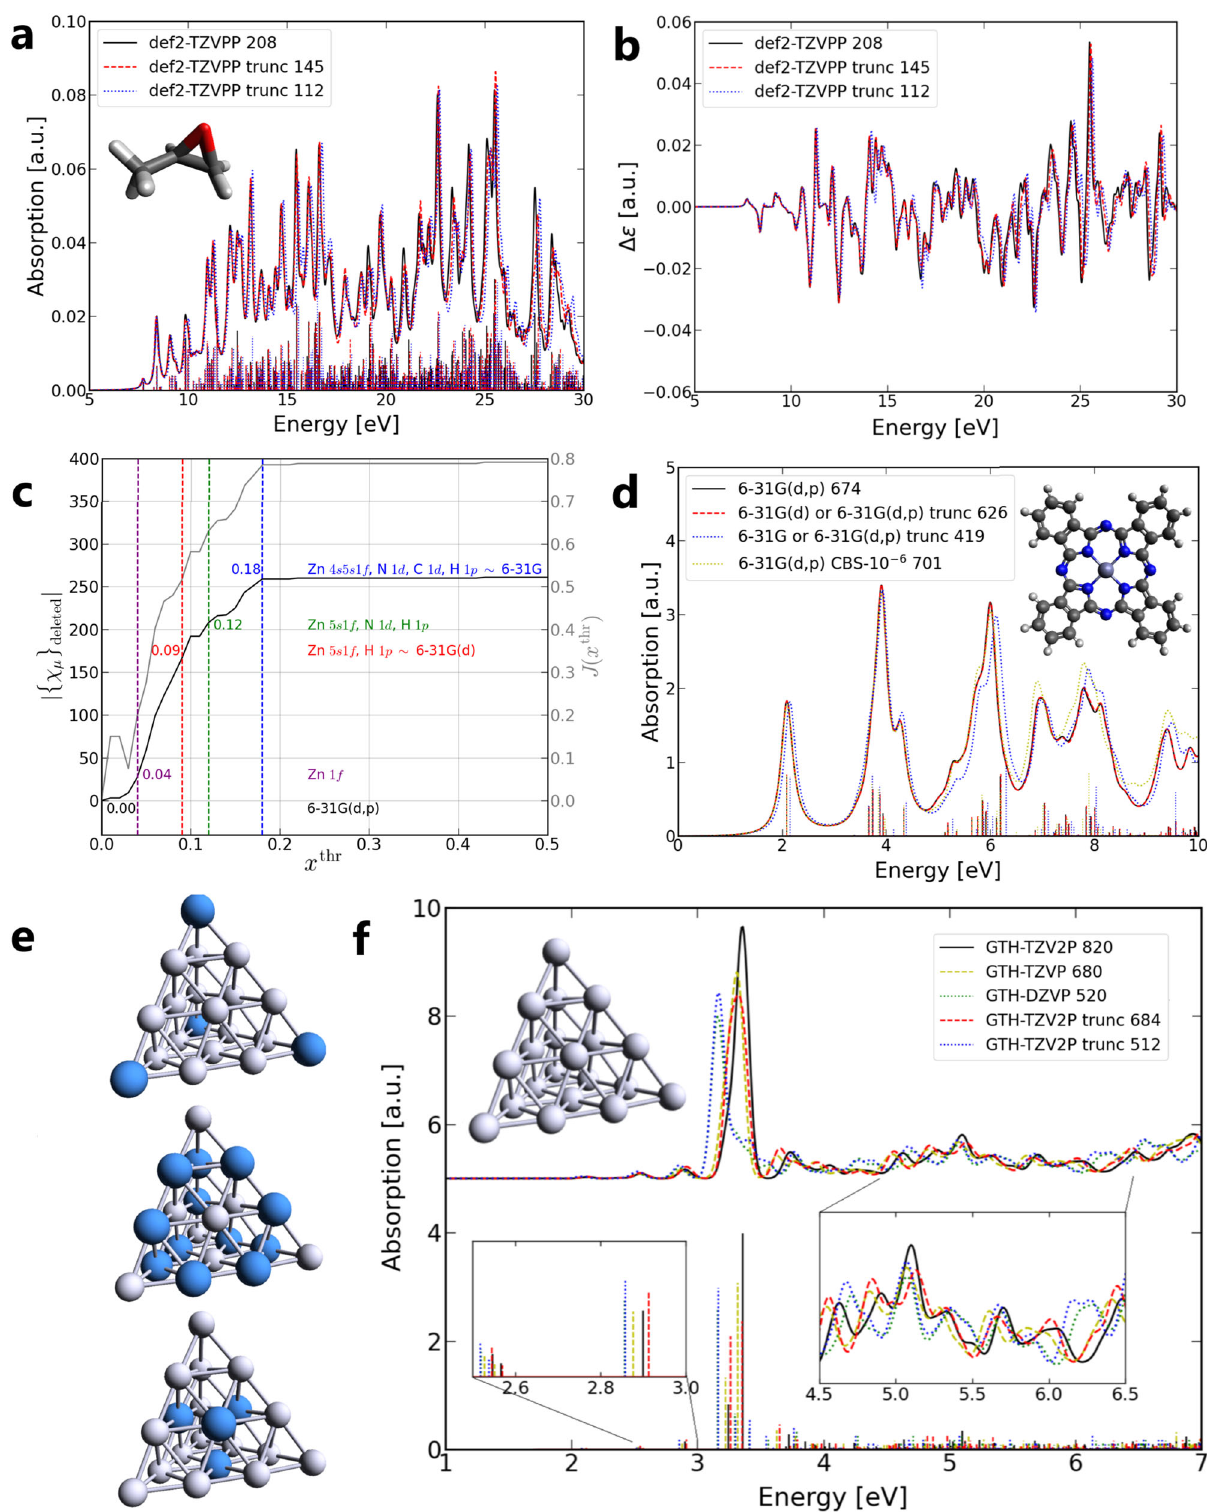
black line than the yellow dashed line. However, the difference between the spectra calculated using “ GTH-TZV2P trunc 512 ” ( x thr